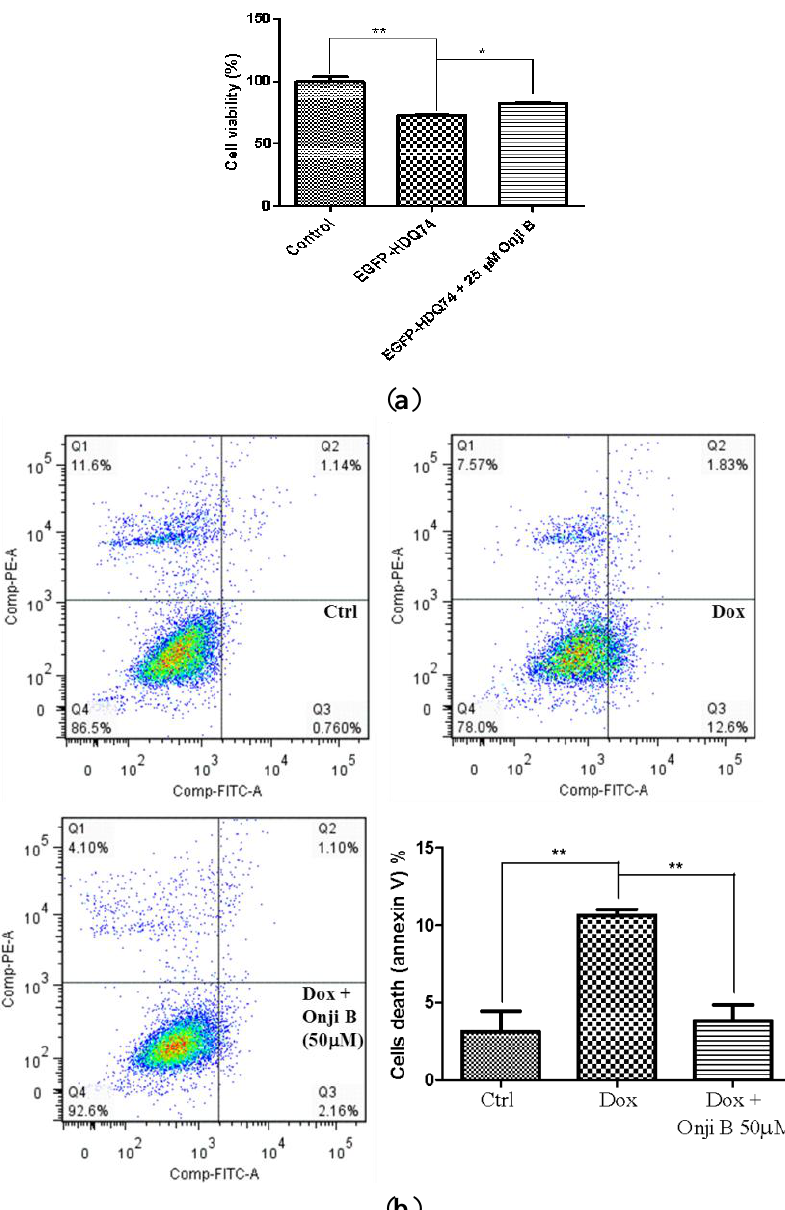
Figure 7. Onjisaponin B reduces toxicity in PC-12 cells expressing either mutant huntingtin or A53T α-synuclein. ( a ) PC-12 cells transfected with huntingtin with 74 CAG repeats for 12 h were treated with 48 h of onjisaponin B. Cell death was assessed by MTT assay; ( b ) Doxycycline-inducible PC-12 cell lines transfected with mutant A53T α-synuclein were induced with doxycycline (1 μg/mL) for 24 h and the expression of transgene was then switched off by the removal of doxycycline. Cells were then treated with onjisaponin B (50 μM) for a further 24 h after doxycycline removal. Ctrl: cells without the addition of doxycycline; Dox: cells with the removal of doxycycline (1 μg/mL) after 24 h of induction but without onjisaponin B treatment. Cell death was then assessed by flow cytometry. Data from the bar chart represented the means ± S.D. of three independent experiments. ** p < 0.01; * p <